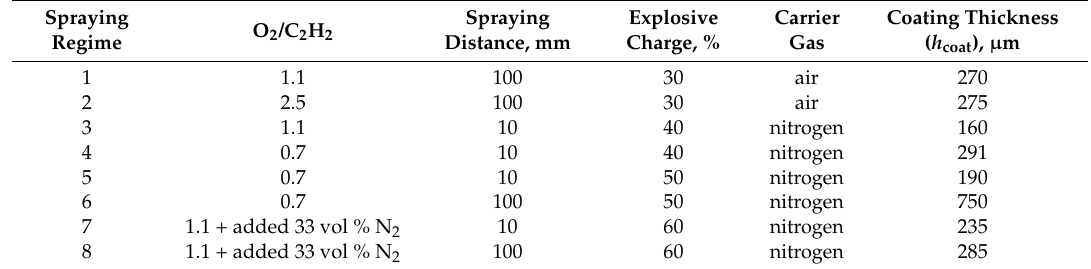
Table 1. Parameters of detonation spraying and the coating